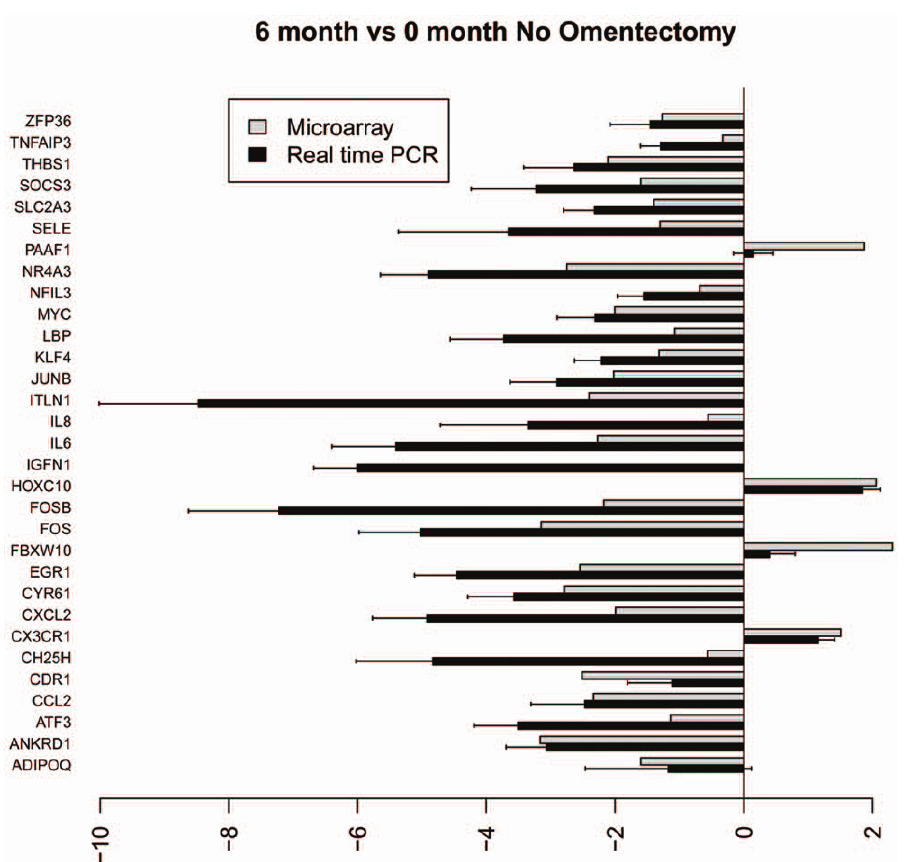
Figure 4. Bar graph illustrating the fold change of individual genes at 6 vs. 0 months without omentectomy as determined by microarray (grey) and TLDA profiling (black).